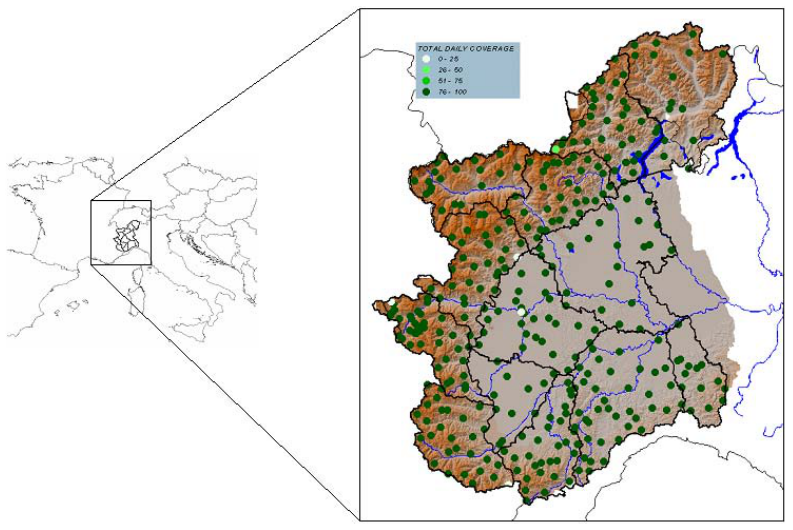
Fig. 1. Domain of the verification, with the 13 warning areas and the network distribution (dots). The colors of the dots indicate the total daily coverage of the rain gauges during the considered period, that is the percentage of days in which the gauges were active.